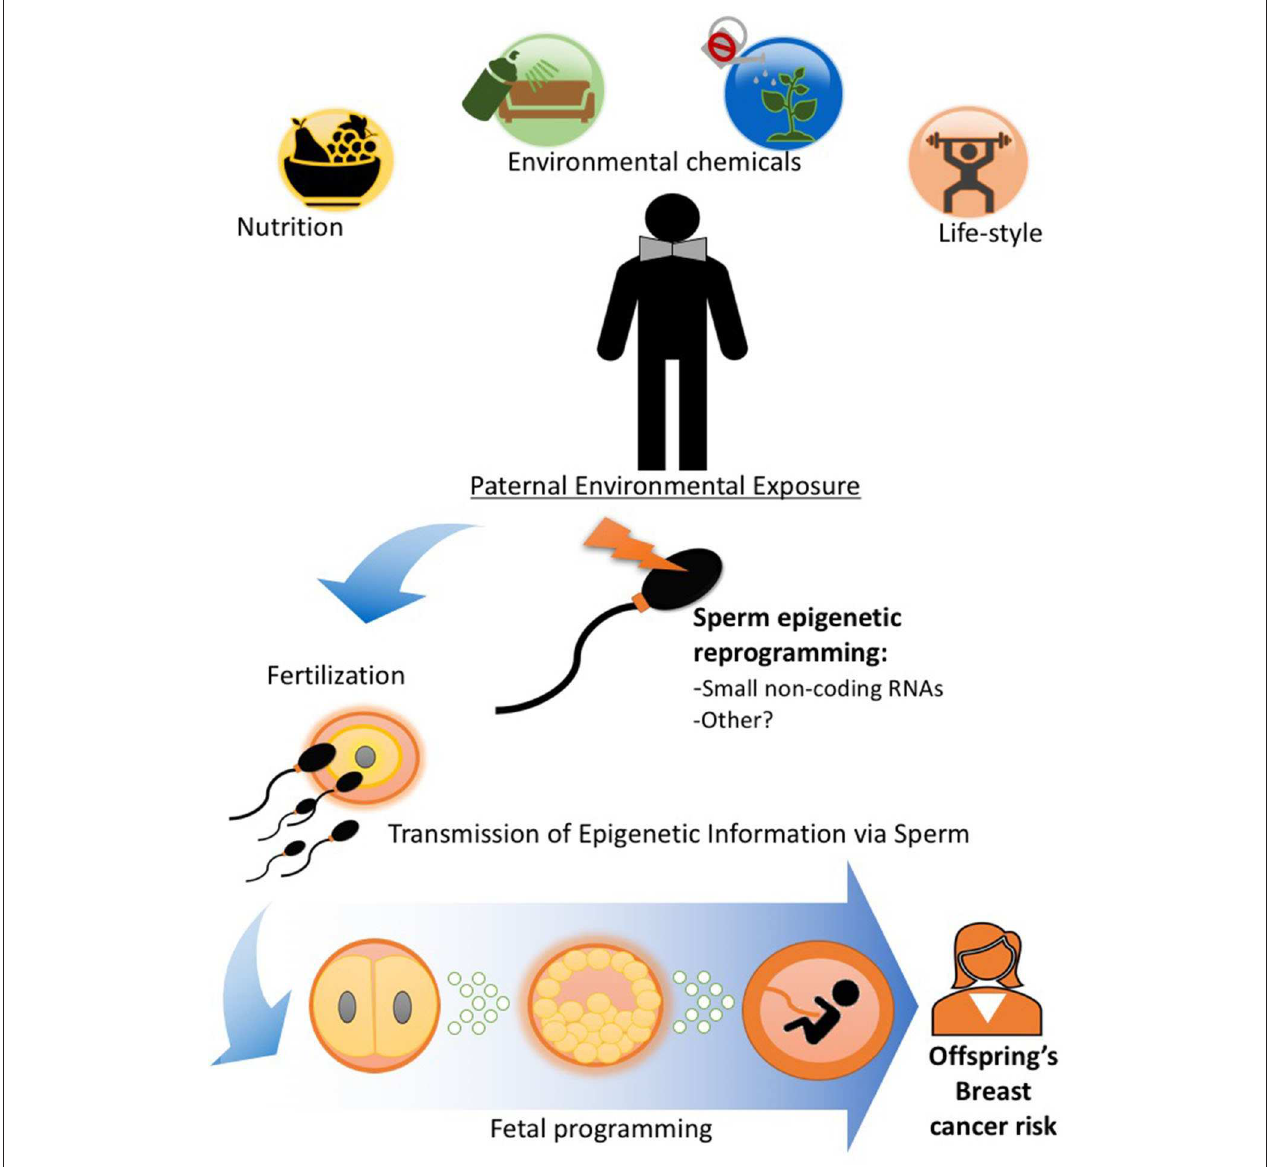
FIGURE 2 | Paternal exposures and epigenetic inheritance of breast cancer. Pre-conception paternal nutritional status and exposure to other lifestyle and environmental factors can epigenetically reprogram the sperm, particularly its small non-coding RNA load. Epigenetic information in sperm can be delivered to the oocyte during fertilization (55) and impact embryonic and fetal tissue development, including that of the mammary gland and alter breast cancer predisposition in offspring. Evidence in human and animal studies support the idea that epigenetic inheritance of breast cancer predisposition can be transmitted through the male germline (6, 7, 10, 40, 41,